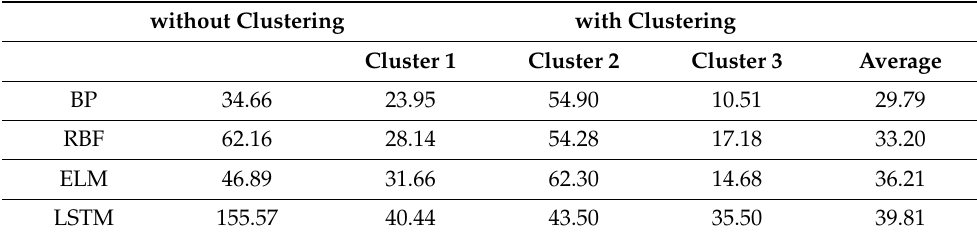
Table 7. RMSE of solar radiation forecast errors in winter.